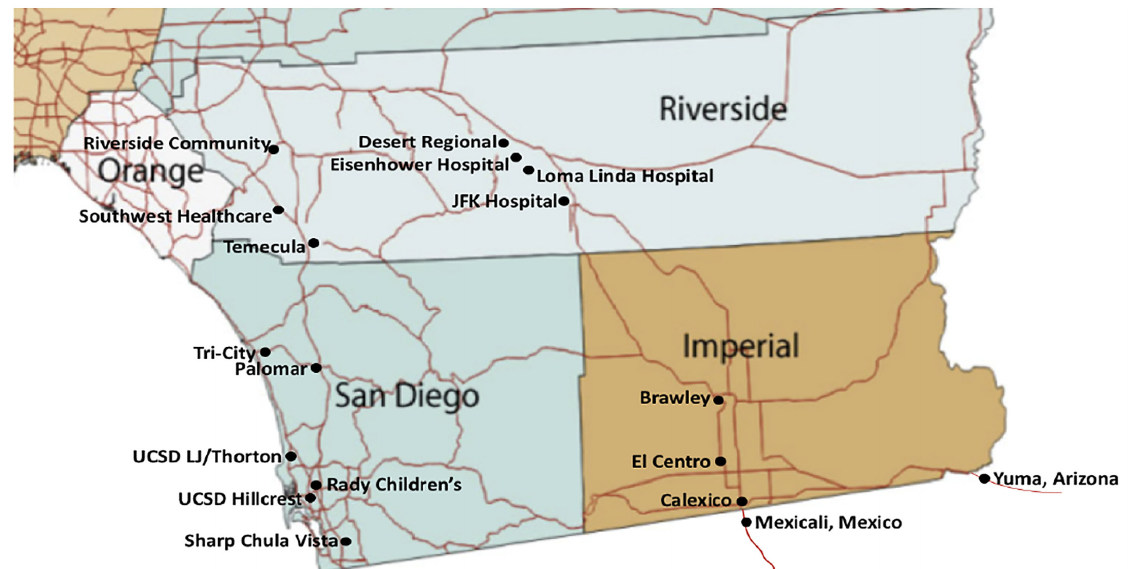
Figure. Map of Imperial County in southern California and surrounding